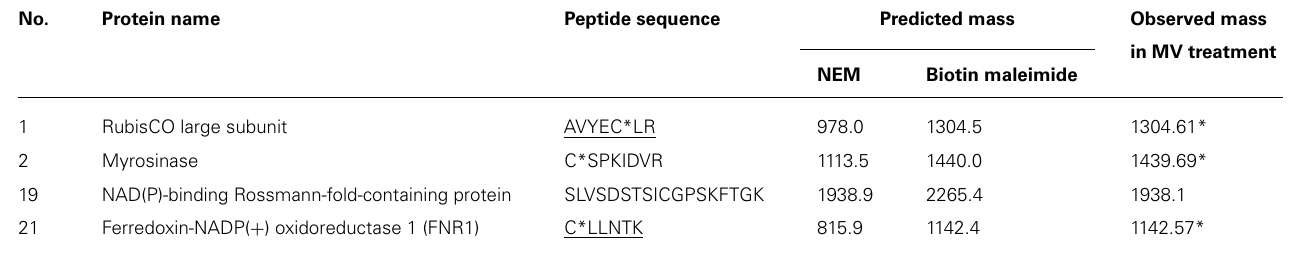
Table 4 | Cysteines modified upon methyl viologen-mediated